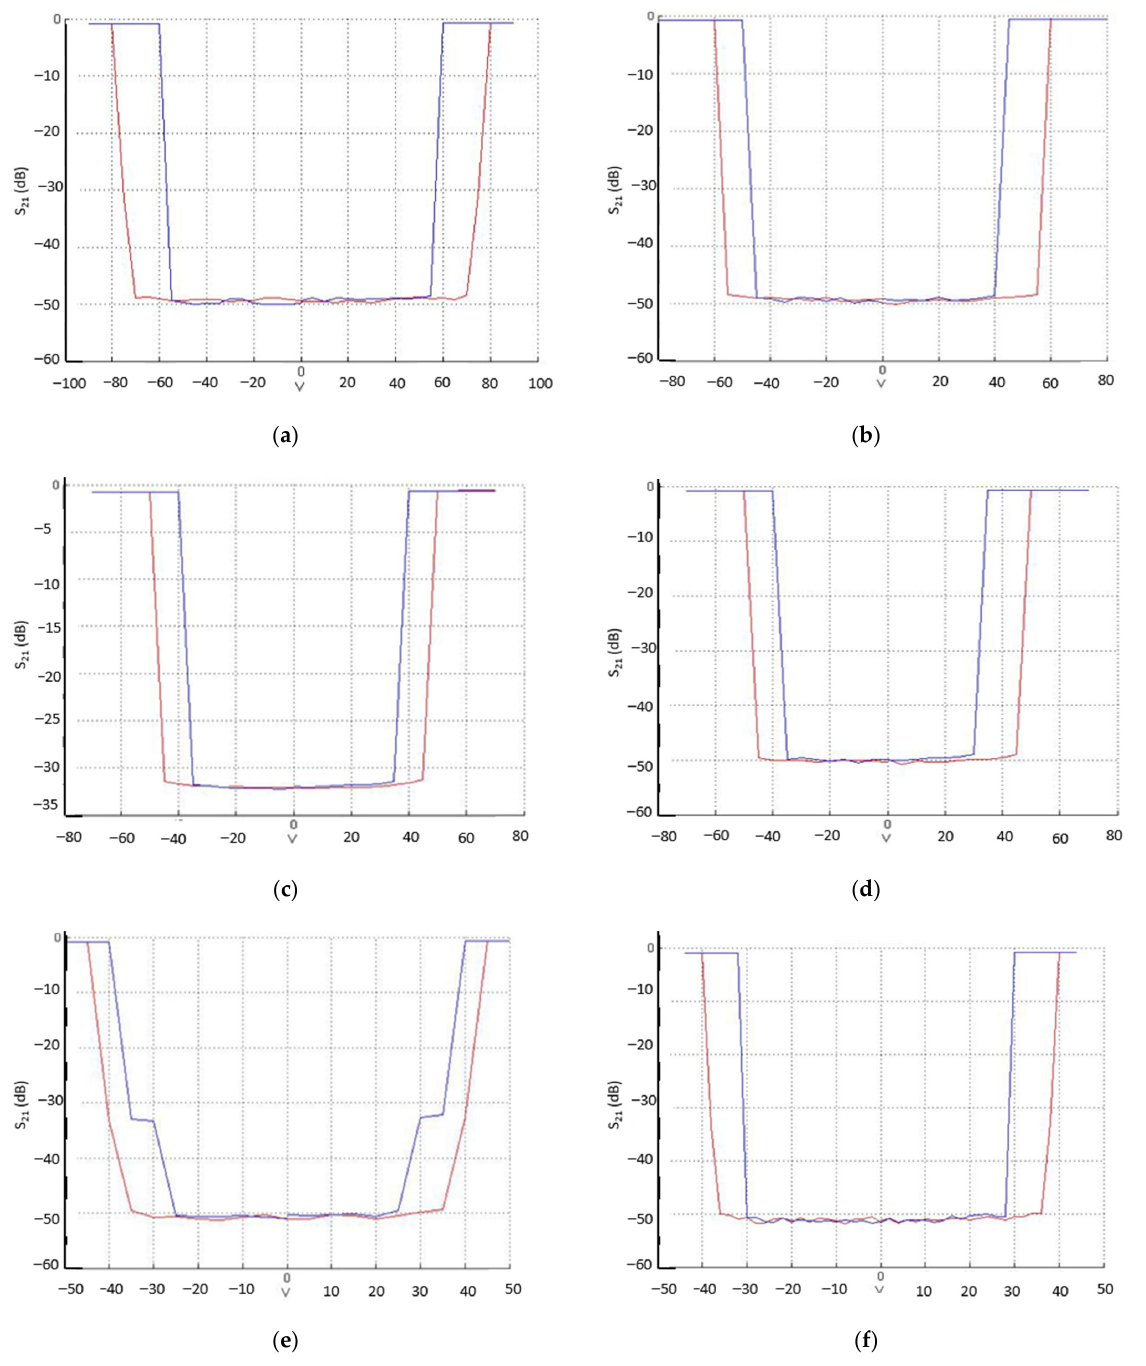
Figure 11. Hysteresis measurements of the fabricated series switches with two ohmic ‐ contacts (g 0 = 2.7 μ m). Red trace: voltage variation from 0 V to ± V pull ‐ in . Blue trace: voltage variation from ± V pull ‐ in to 0 V, showing ± V pull ‐ out . ( a ) DDG ‐ W ‐ DL, ( b ) DDG ‐ NW, ( c ) DDG2 ‐ W, ( d ) DDG2 ‐ NW, ( e ) DG ‐ W, and ( f ) DG ‐ NW.